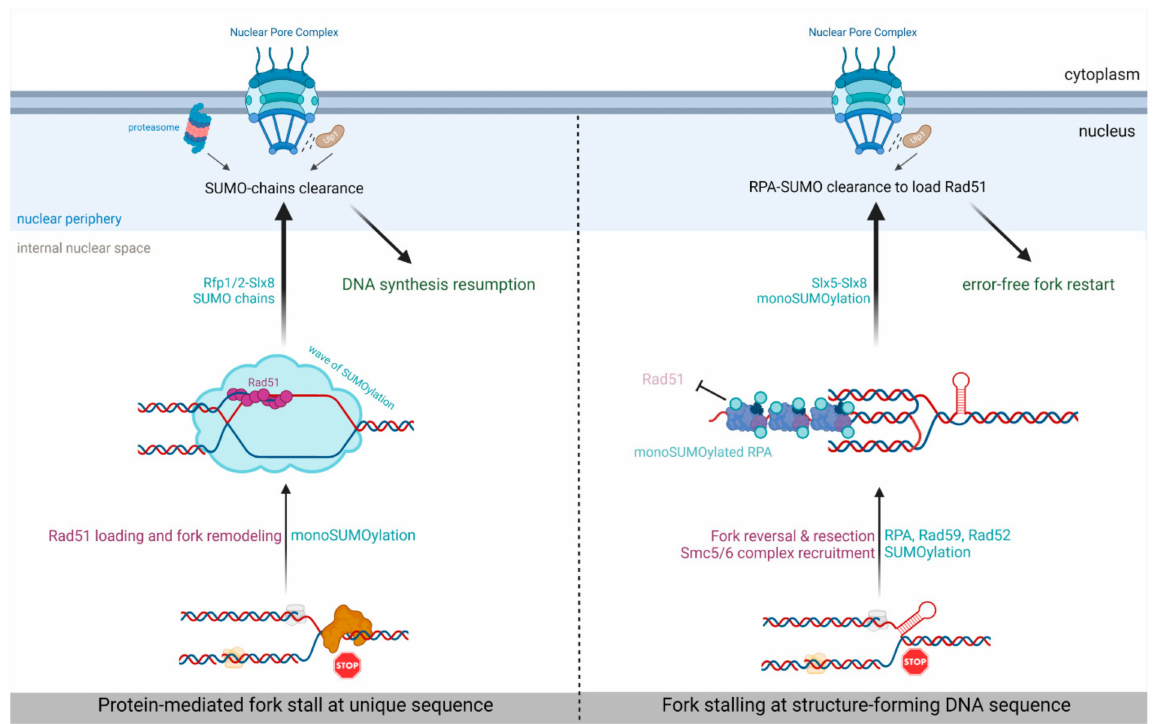
Figure 2. Routing towards NPCs for DNA-bound, protein-mediated fork arrest ( left panel) and structure-forming-mediated fork stalling ( right